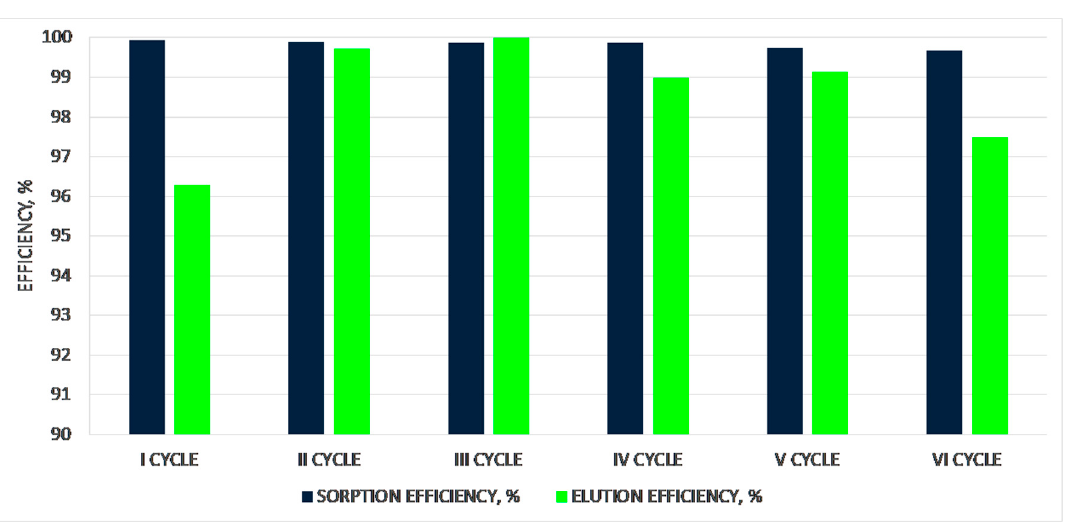
Figure 6. Sorption and elution efficiency of nickel (II) ions in six subsequent cycles of ionite C160 work. Obtained solutions were combined, neutralized and appropriate compounds (nickel(II) perrhenate and its mixture with cobalt) were separated. Compositions of the prepared substances after drying are shown in Table 21. Table 21. Composition of nickel(II) perrhenate and its mixture with